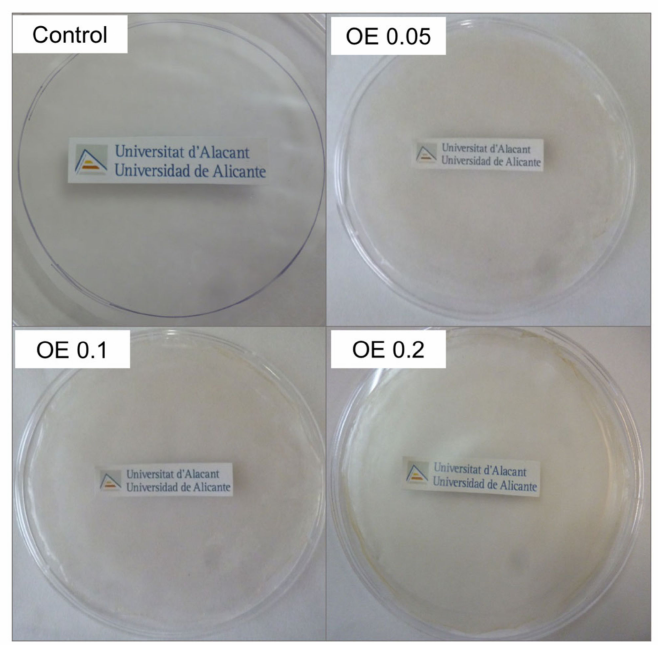
Figure 5. Visual appearance of the obtained edible